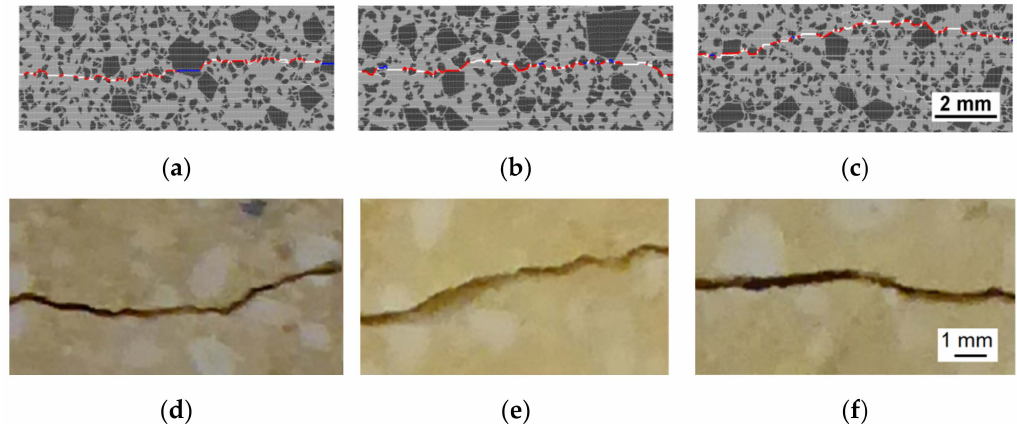
Figure 6. Crack patterns of the model samples under uni-axial tension ( a – c ) and typical crack patterns in the real samples under three-point bending ( d – f ). White, blue, and red portions of the crack lines in ( a – c ) indicate crack propagation through matrices, through grains, and along interfaces, respectively. The width of each image represents 1 cm of the sample. See also Supplementary Materials with full-size ( a – c